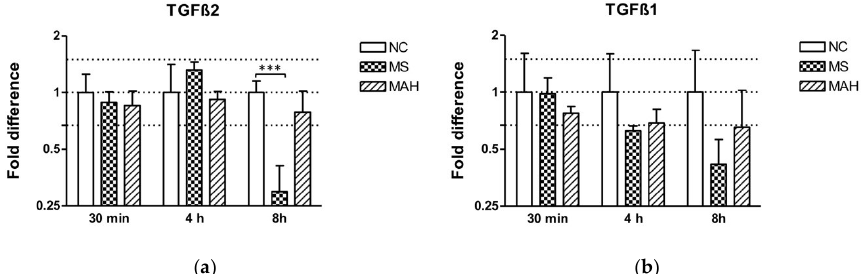
Figure 3. Expression of TGF- β 2 and TGF- β 1 in macrophages infected with M. smegmatis (MS, dotted columns) and M. avium subsp. hominissuis (MAH, dashed columns) compared to the negative control (NC, white columns), n = 3. ( a ) Expression of TGF- β 2 is clearly reduced in MS-infected cells 8 h p.i. ( b ) Expression of TGF- β 1 is downregulated by MS 8 h p.i. Asterisks summarize p -values (unpaired t -test; *** p < 0.001). Columns show means of three biological replicates ( n = 3) and bars show